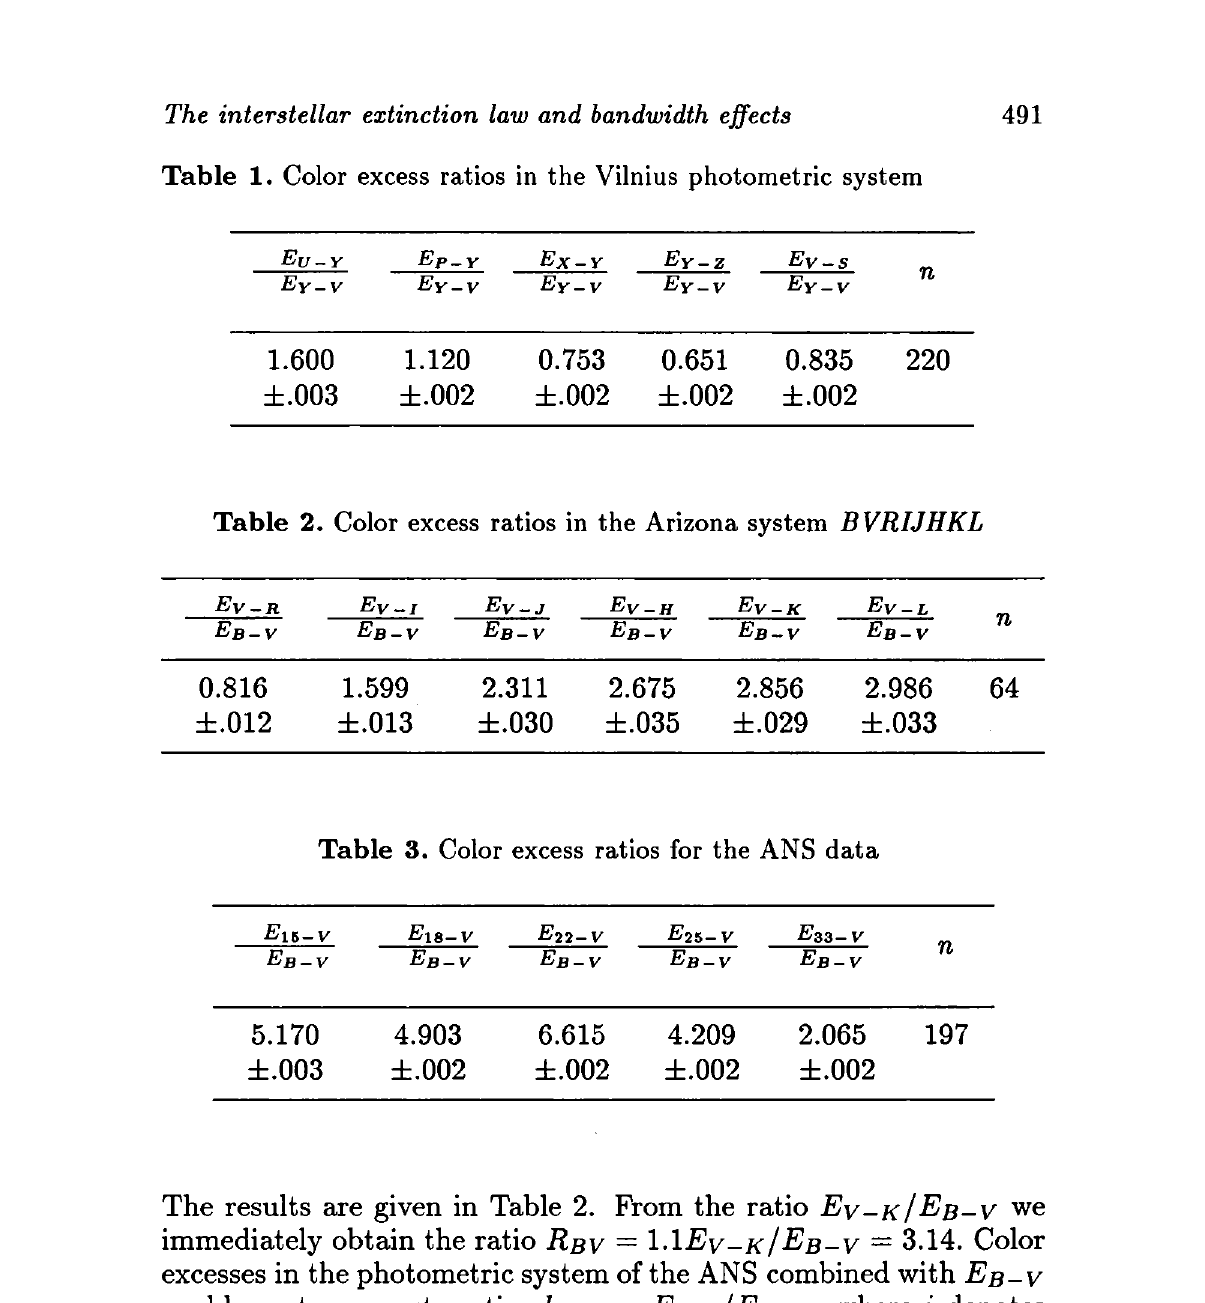
Table 3. Color excess ratios for the ANS